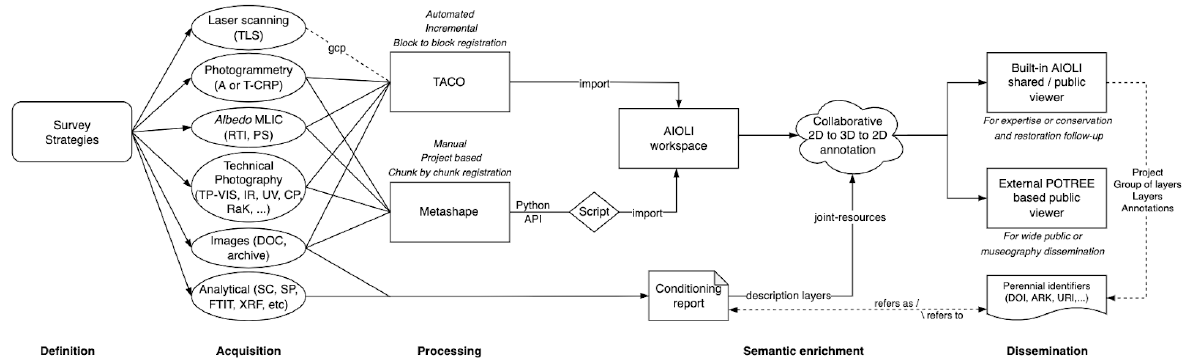
Figure 6 . Overview of the semantically enriched workflow developed